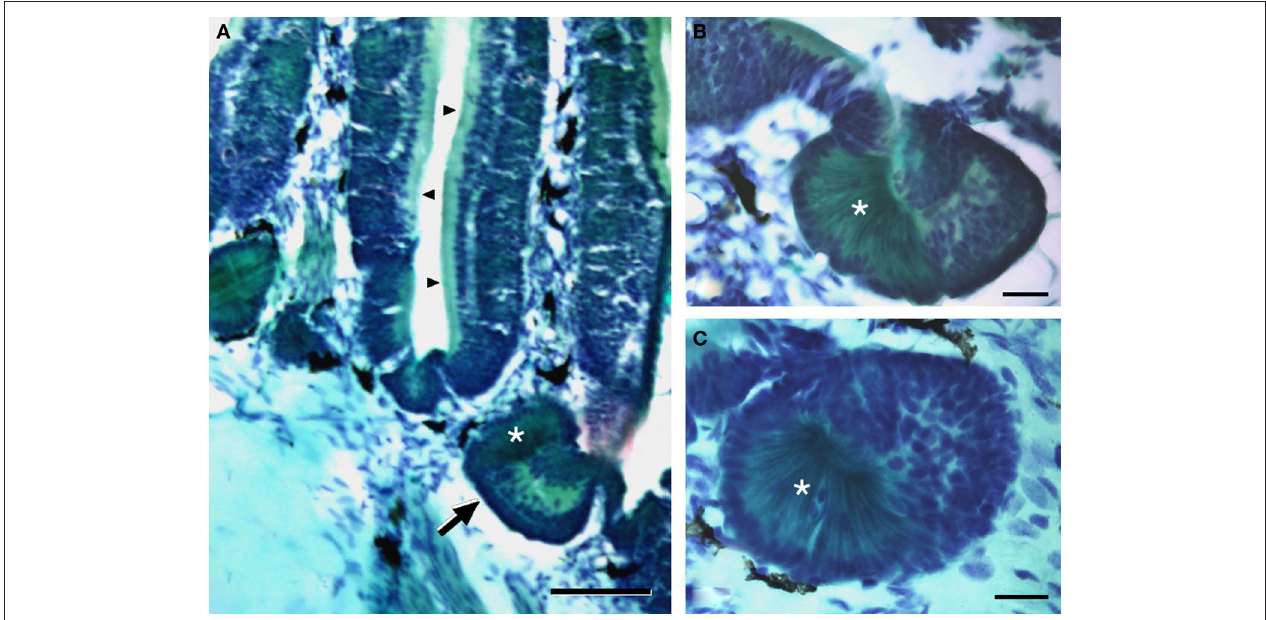
Figure 1 | The olfactory organ of Protopterus contains a series of suspended lamellae and epithelial crypts that lie at the base of the lamellae. (A) Histological sections of Masson’s trichromic stain of the olfactory organ illustrating the olfactory lamellae with the sensory epithelium